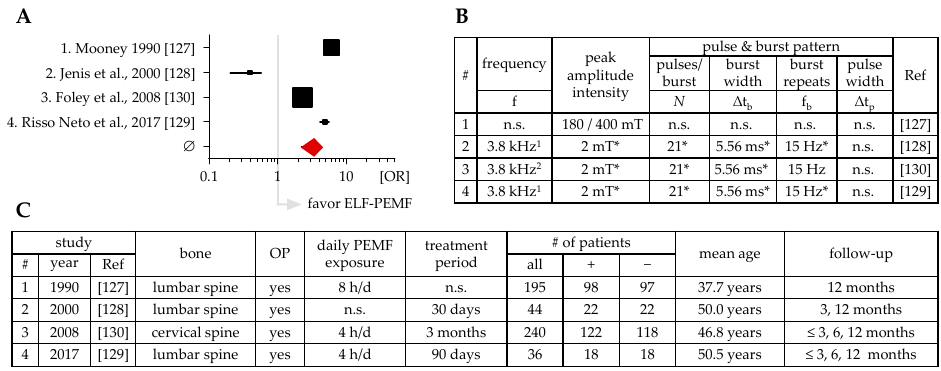
Figure 7. Clinical studies (prospective, placebo-controlled, blinded) investigating the effect of ELF-PEMF treatment on spinal fusion. ( A ) Forest plot showing OR ± 95% C.I.—sum was calculated as described by Neyeloff et al. [107], with weighting based on sample size. ( B ) Tabular overview of the ELF-PEMF used in the presented studies. ( C ) Tabular overview of the presented studies including a ff ected bones, basic information on the treatment and follow up, as well as the number of patients